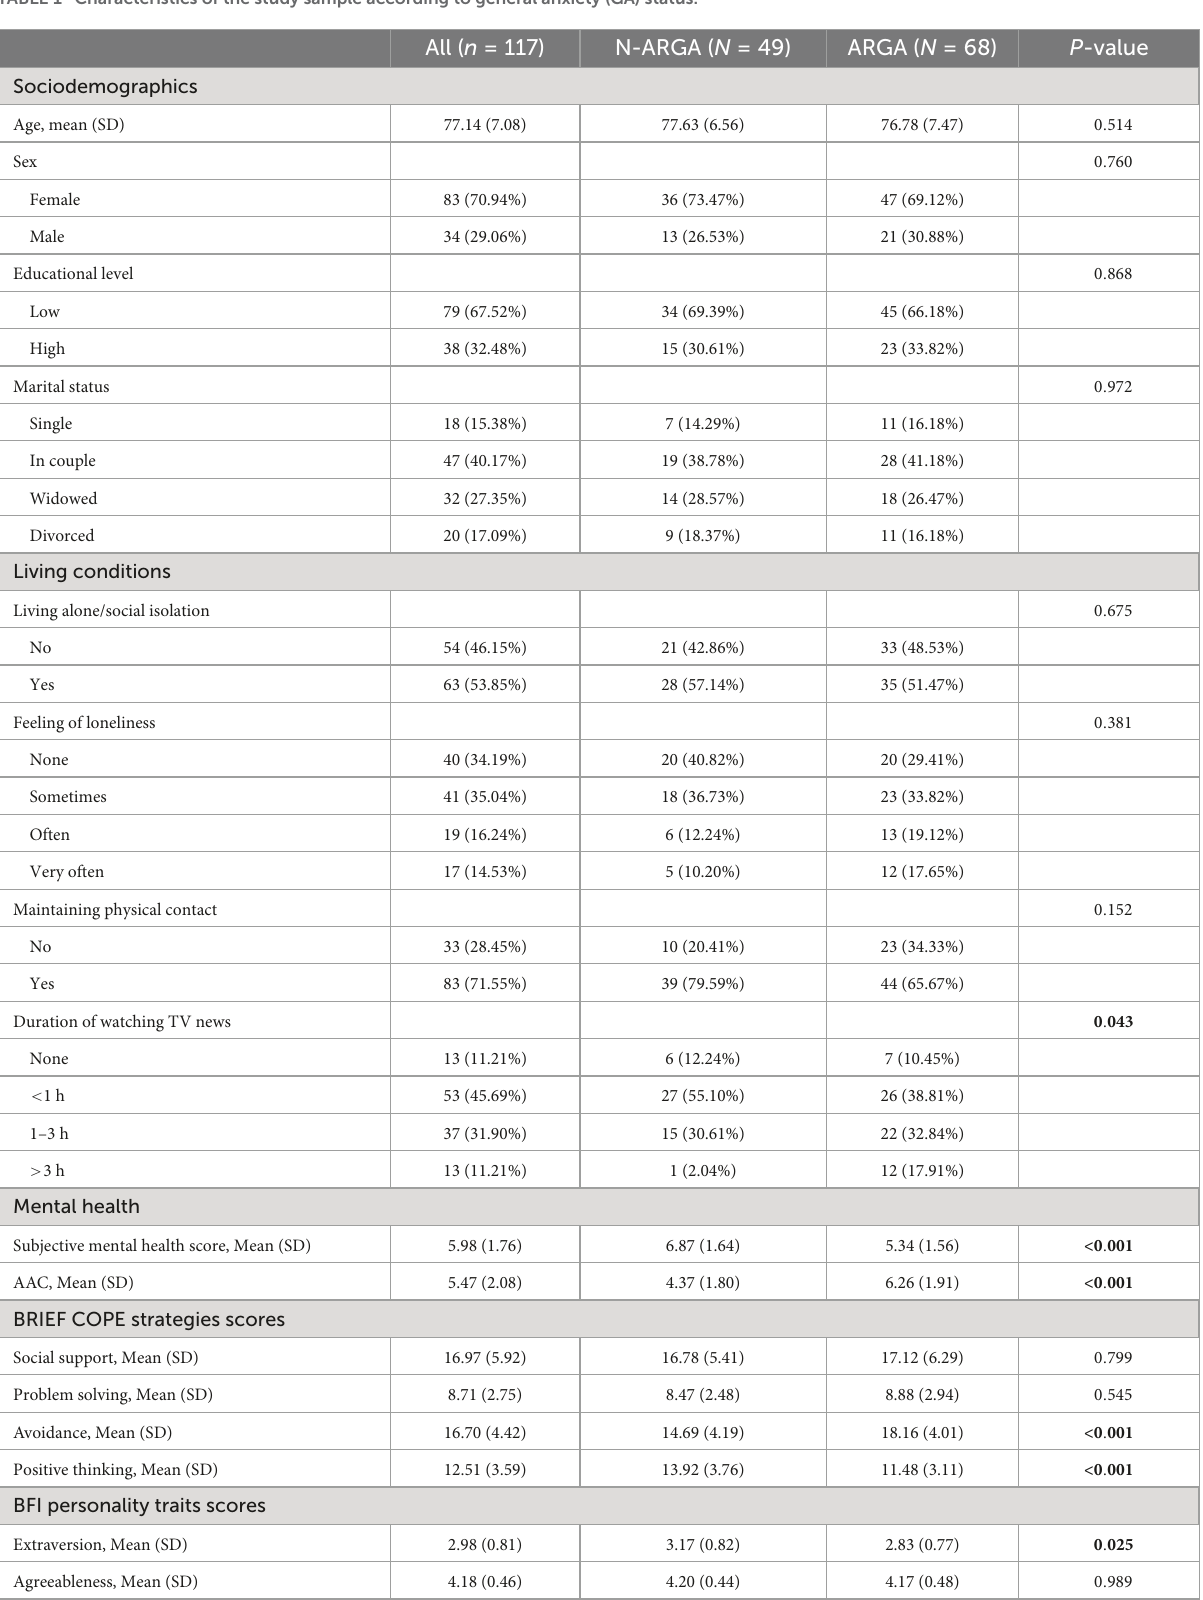
TABLE 1 Characteristics of the study sample according to general anxiety (GA)